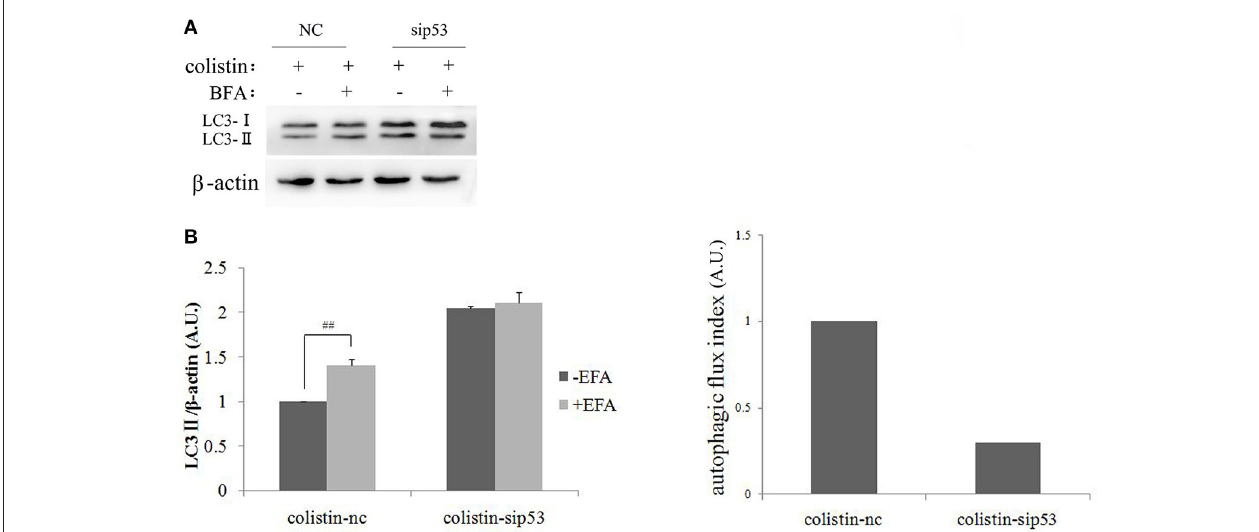
FIGURE 3 | Autophagic flux in PC-12-sip53 cells with colistin treatment. (A) PC-12 cells and PC-12-sip53 cells were treated with colistin (125 µ g/mL) for 24h, respectively after the absence and presence of BFA at 3h. (B) Western blot assaying on the levels of LC3-II/I. The β -actin level was used as the internal standard. Bar graph represents the mean percentage ± SD , whereas n = 3. ## p < 0.01 vs. control group. (C) Autophagic flux indexes were calculated from the data illustrated in (B) as the difference in LC3-II/ β -actin ratios with or without BFA, expressed in arbitrary units (a.u.).